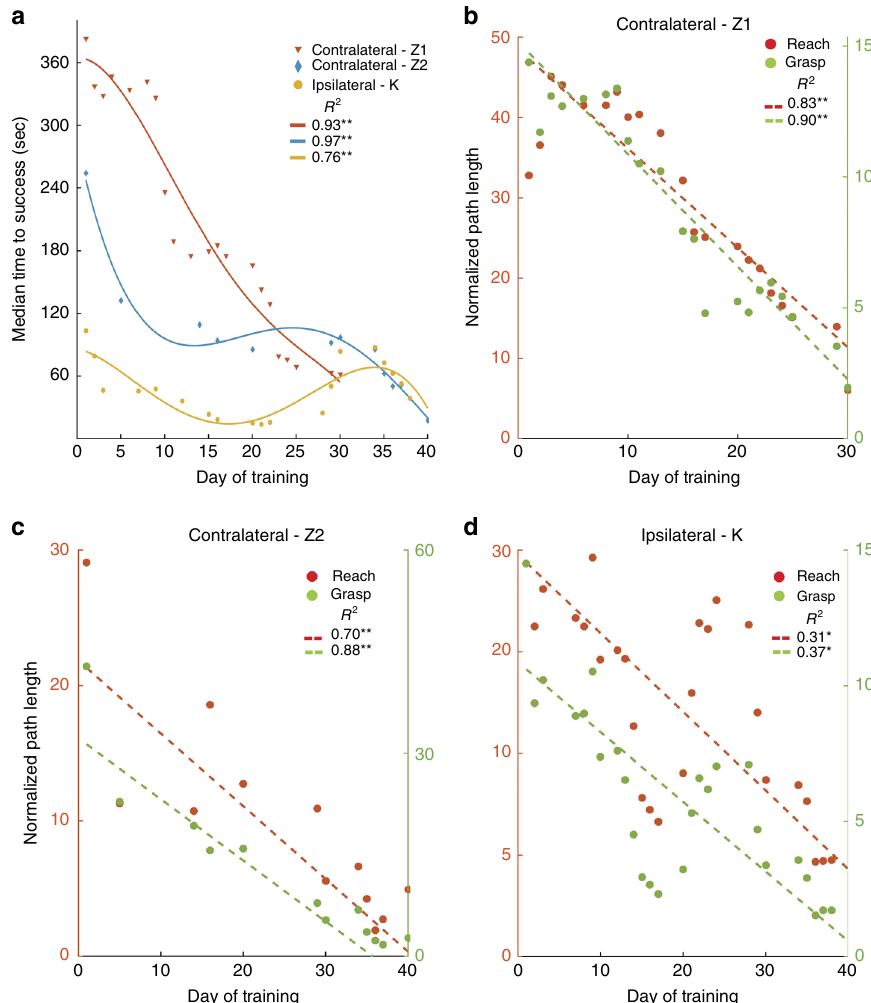
Fig. 1 Behavioral performance of the subjects. a shows the median time to success over BMI training. Time to success refers to the time taken to perform a successful trial of the reach-grasp-pull-release task. The discrete points in the plot correspond the actual data, and the solid lines show a fourth order polynomial fi t to the data. b – d shows the improvement in mean normalized path lengths of reach and grasp movements. Normalized path length refers to the total path traveled by the robotic arm to complete a successful trial divided by the shortest path possible. The dotted lines represent least-square fi t for the data (shown as discrete points). ** p < 0.001 and * p <